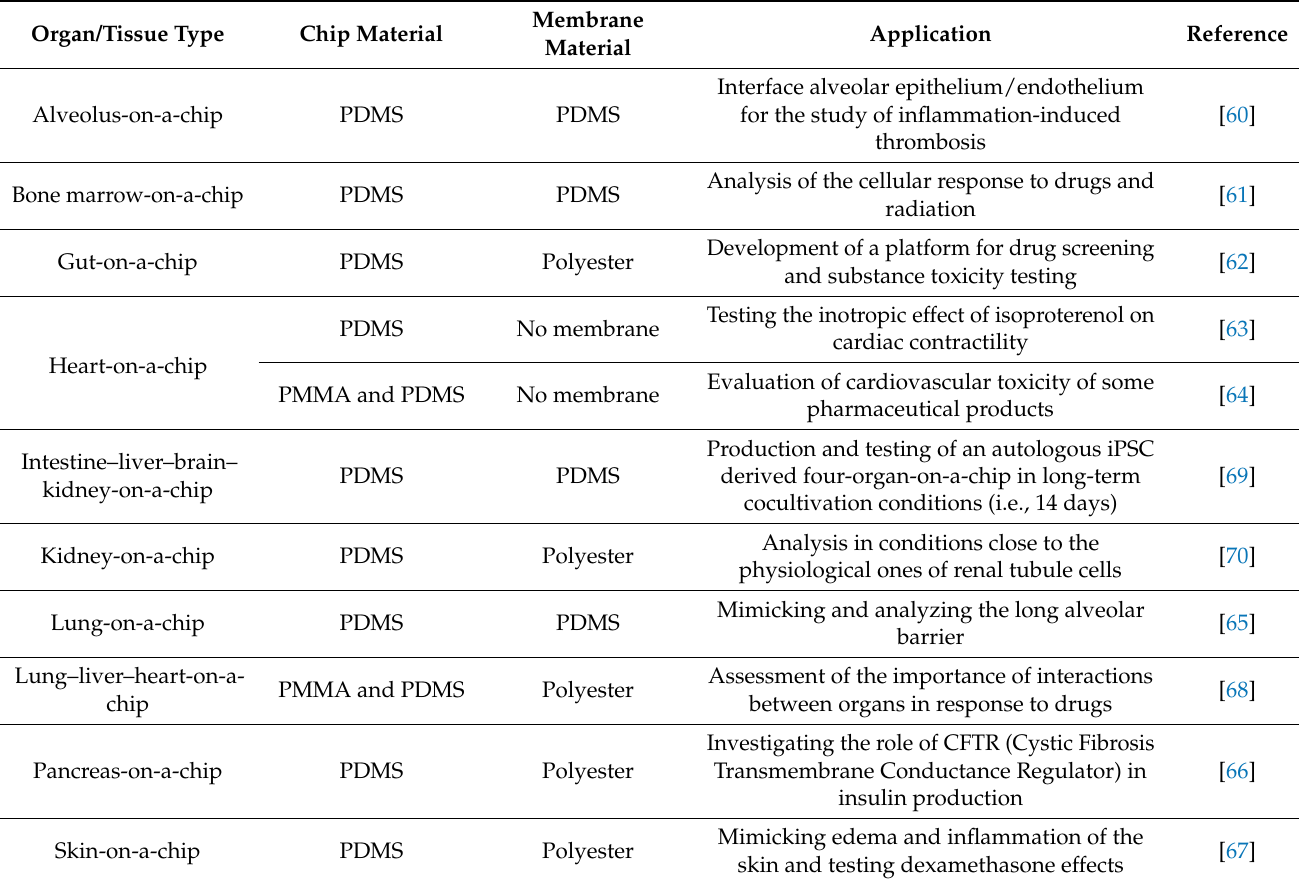
Table 2. Organ-on-a-chip